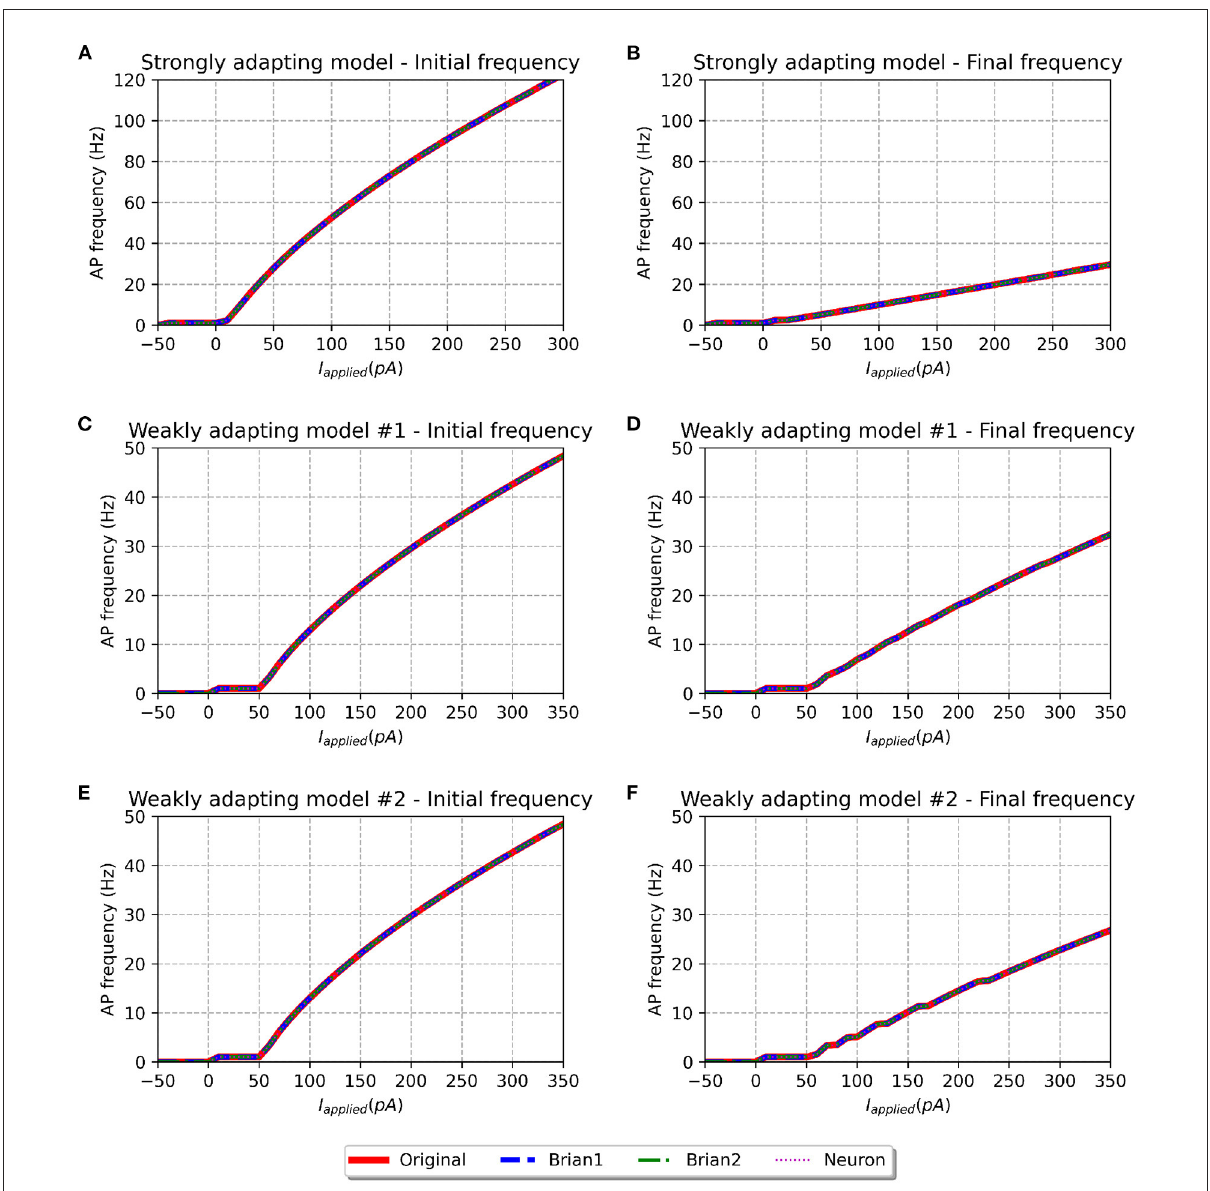
FIGURE5 f-I curve for the various models when run with initial membrane potential = − 55 mV. Panels on the left show the initial f-I curve, while those on the right show the final f-I curve. It can be observed that the rheobase current is reduced as compared to f-I curves with initial potential of − 65